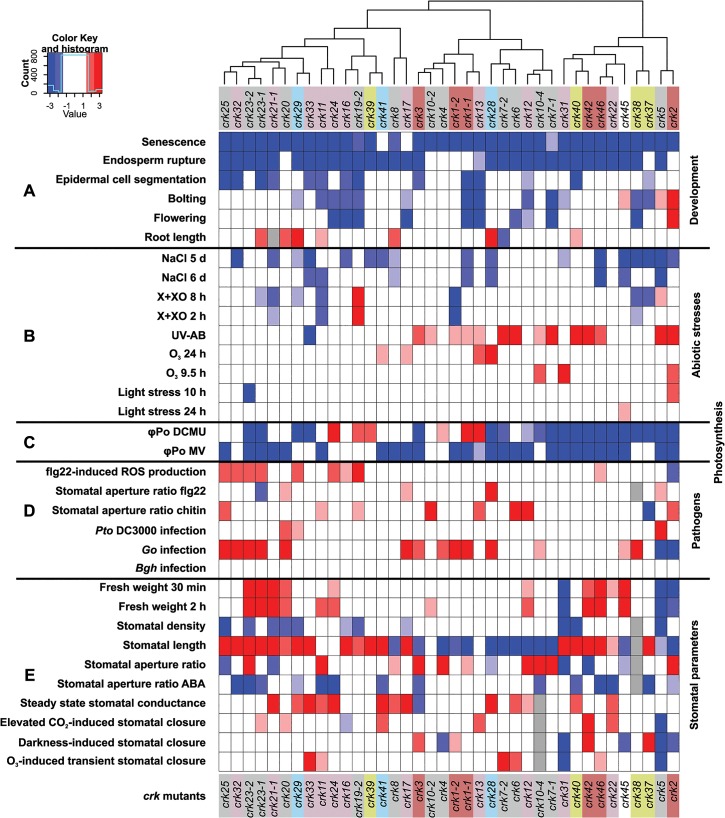
Integrated cluster analysis of crk mutant phenotypes.An age-matched collection of T-DNA insertion lines in CRK genes was analyzed for developmental and stress-related phenotypes. (A) Analysis of developmental phenotypes of crk mutant lines: senescence, germination (endosperm rupture), epidermal cell segmentation, bolting, flowering, and root length. (B) Analysis of abiotic stresses phenotypes of crk lines: germination of crk lines on medium containing NaCl, cell death (measured by electrolyte leakage) in response to Xanthine-Xanthine Oxidase (X+XO), ultraviolet light (UV-AB), ozone (O3), or light stress. (C) Analysis of photosynthesis responses upon treatment with DCMU or methyl viologen (MV). (D) Pathogen phenotypes. ROS production in response to treatment with the bacterial elicitor flagellin (flg22). Stomatal aperture ratio in response to flg22 and chitin treatments and crk susceptibility to the hemibiotrophic bacterial pathogen Pseudomonas syringae pv. tomato DC3000 (Pto infection) or the biotrophic fungal pathogens Golovinomyces orontii (Go) (virulent on Arabidopsis) or Blumeria graminis f.sp. hordei (Bgh, a barley pathogen, non-pathogenic on Arabidopsis). (E) Analysis of stomatal parameters: fresh weight (for determination of water loss), density, length, aperture, stomatal aperture in response to ABA treatment, steady state stomatal conductance, stomatal closure in response to elevated CO2, O3, and darkness. Experiments were made comparable by bootstrap sampling to n = 15 followed by averaging over bootstrap estimates. Red and blue indicate statistically significant increase or decrease in response compared to Col-0 wild type, respectively, while white indicates a response that is similar to wild type Col-0. The intensity of color is proportional to the Benjamini-Hochberg false discovery rate (FDR) adjusted Z statistic which takes the estimated means and their variation into account. As a rough guideline, |Z|>1.67 corresponds to a FDR<10% (shown with light hue), and |Z|<2.6 to a strong FDR<1% (intense color). White: non-significant response; grey: not measured. A corresponding plot displaying the adjusted Z statistics without thresholding is shown in S25 Fig.